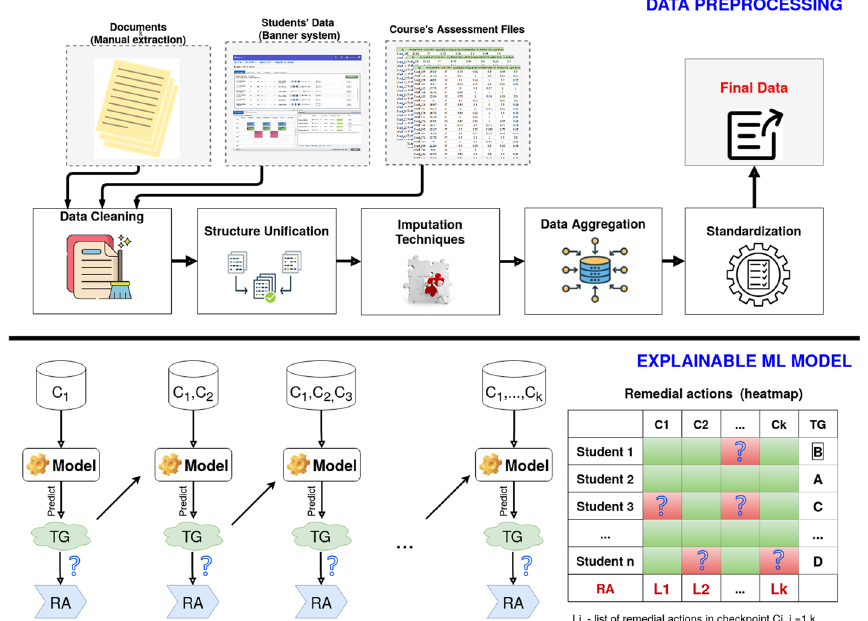
Fig. 2 Pipeline of proposed